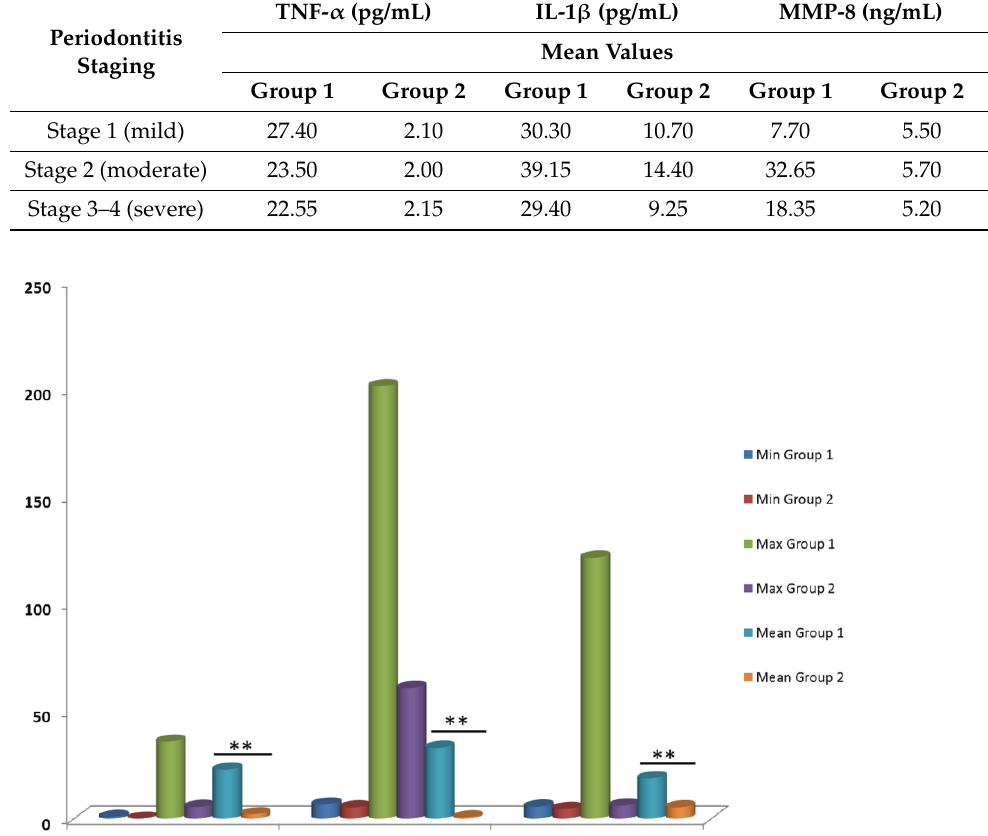
Figure 2. Comparison between inflammatory biomarkers in group 1 vs. group 2 (min—minimum value, max—maximum value, **—statistically significant difference).